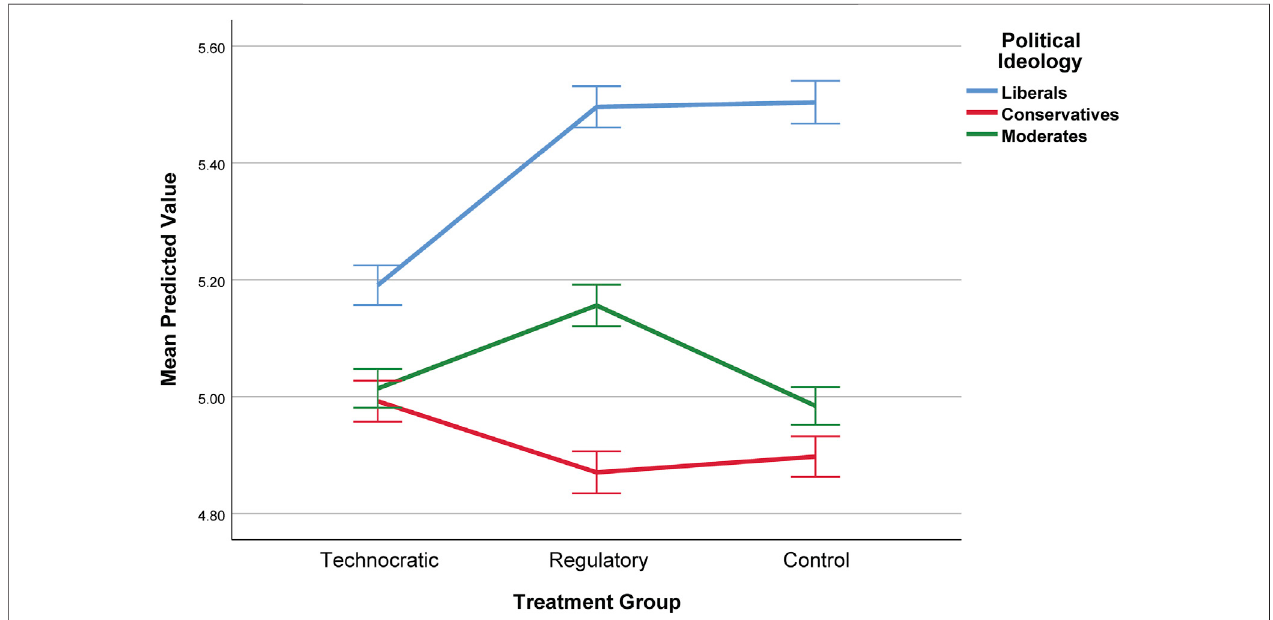
FIGURE6| PredictedmeansbasedonOLSregressionmodel3with95%con fi denceintervalerrorbarsforperceivedvalidityofthe NatureScience study,grouped by political ideology and treatment group.